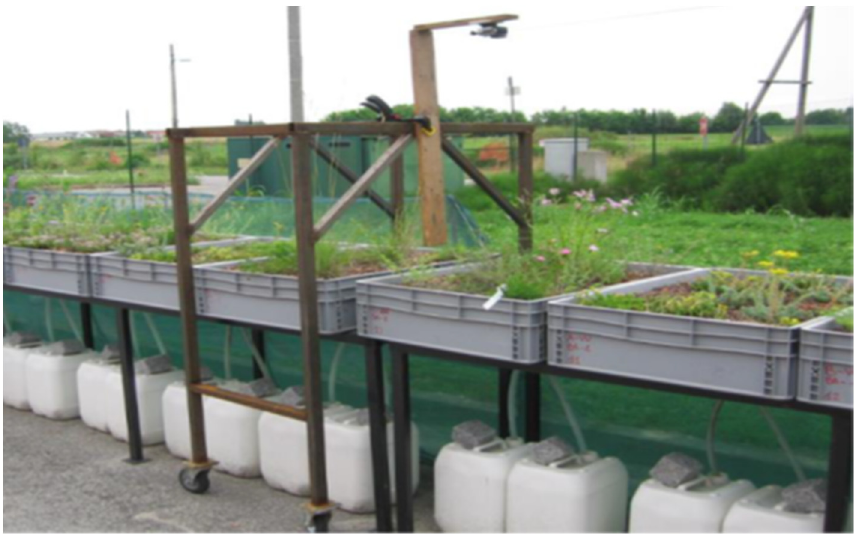
Figure 5. The mobile stand with a camera to take photos of the plant cover.